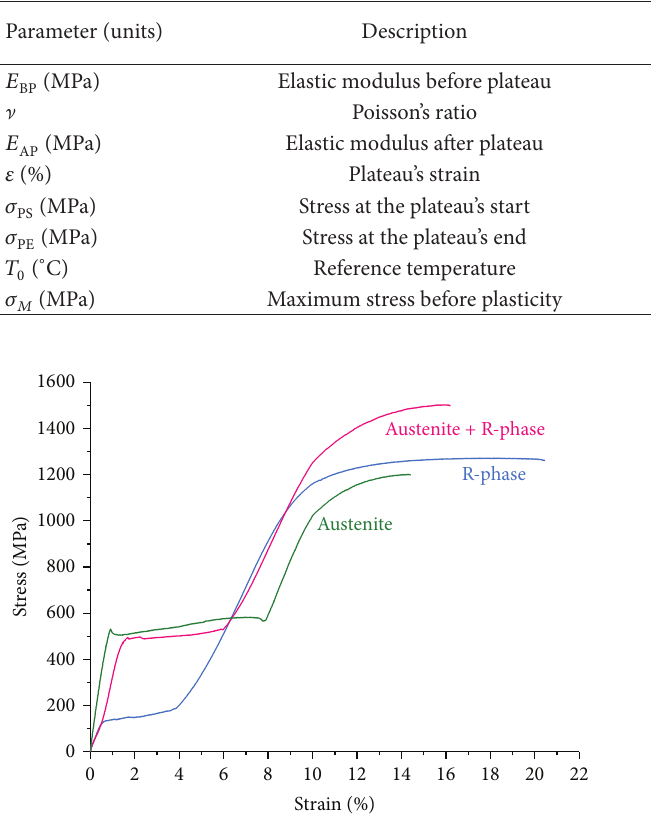
Figure 7: XRD patterns for R-phase as received, after 4% uniaxial strain, and then after heating above